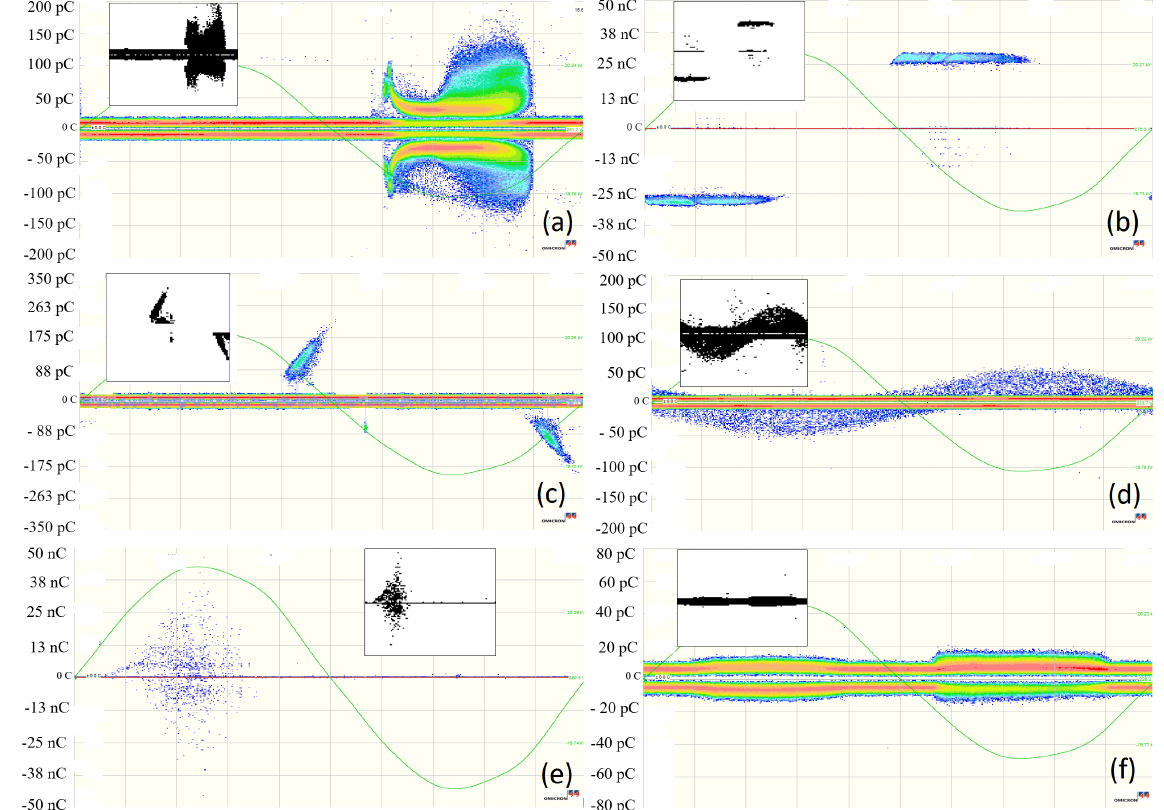
Figure 4. PRPD patterns and their binary representation of various single defects: ( a ) class 1; ( b ) class 2; ( c ) class 3; ( d ) class 4; ( e ) class 5; ( f ) class